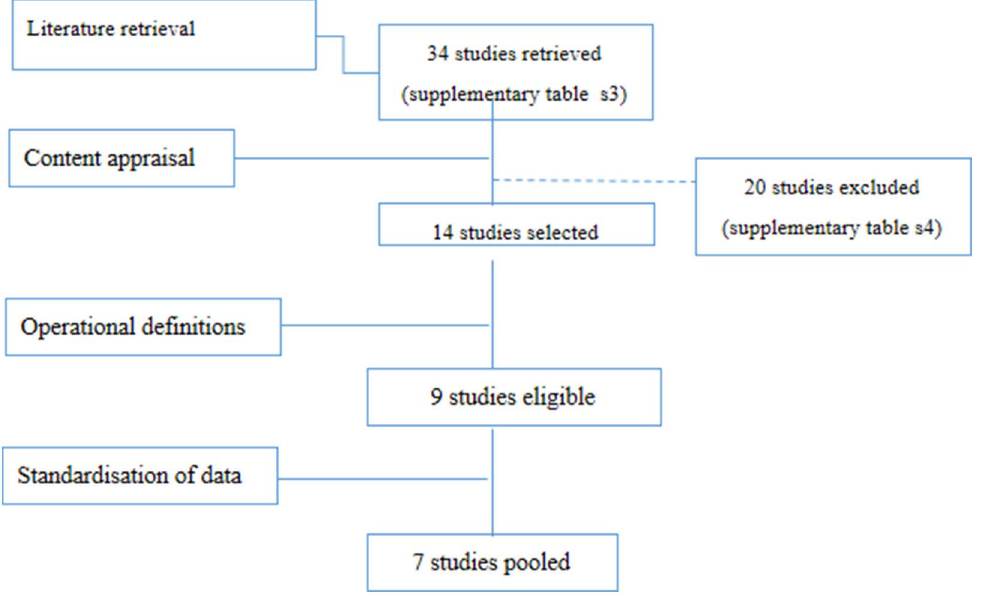
Figure 1. PRISMA-style scheme reporting the literature retrieval and selection strategy arriving to the final 7 studies whose data could be pooled for statistical analysis.